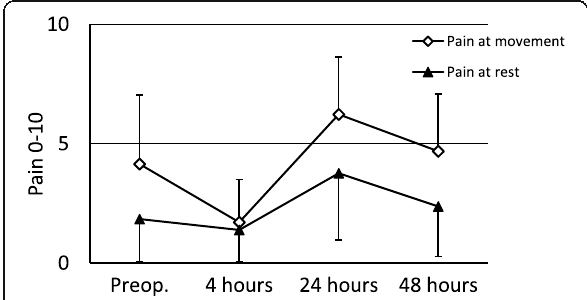
Fig. 2 Pain ratings assessed with numerical rating scale (NRS, 0 – 10) preoperatively, at 4 h, 24 h and 48 h after surgery at rest and at leg movement. Data is presented as mean and standard